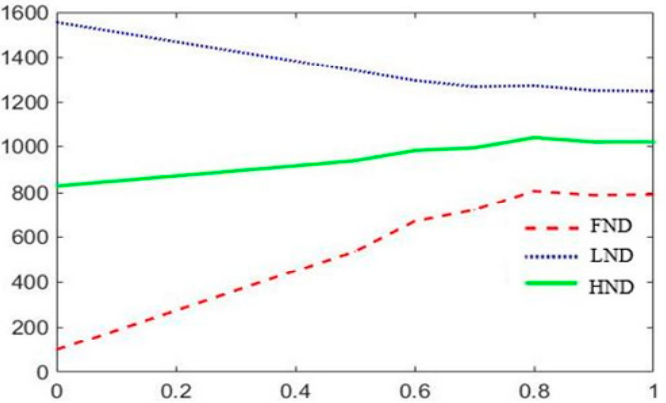
Sensors 2019 , 19 Figure 9. Network lifetime schematic diagram of the trend of w 1. Figure 9. Network lifetime schematic diagram of the trend of w 1.